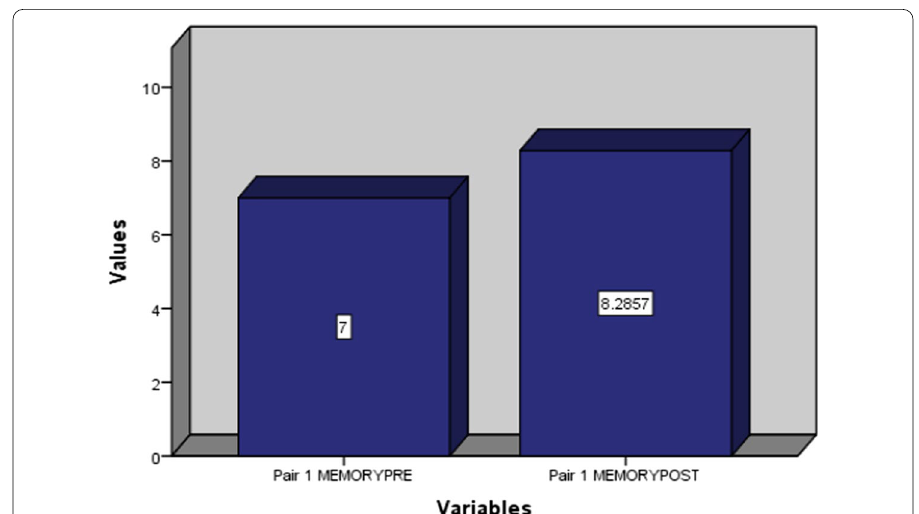
Fig. 4 Paired samples statistics: memory. Source: SPSS 23.0 output